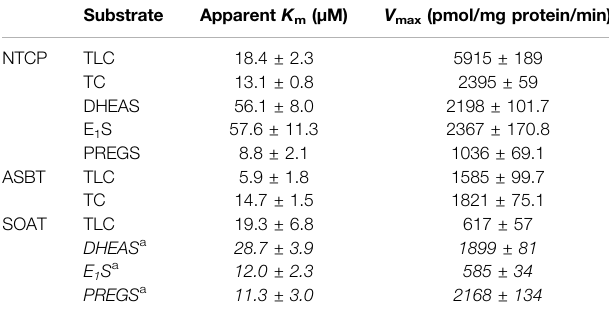
TABLE 2 | Transport kinetic parameters for TLC, TC, DHEAS, E 1 S, and PREGS uptakeviaNTCP,ASBT,andSOAT.Michaelis-Mentenkineticparameters( K m and V max ) were calculated by nonlinear regression analysis from the primary transportdatashownin Figure2 .Valuesrepresentmeans ± SDofcombineddata of two independent experiments, each with triplicate determinations ( n (cid:1)